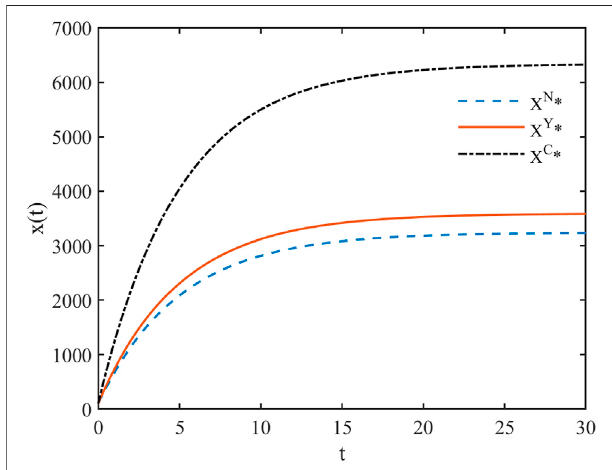
FIGURE 2 | Knowledge stock under different KS